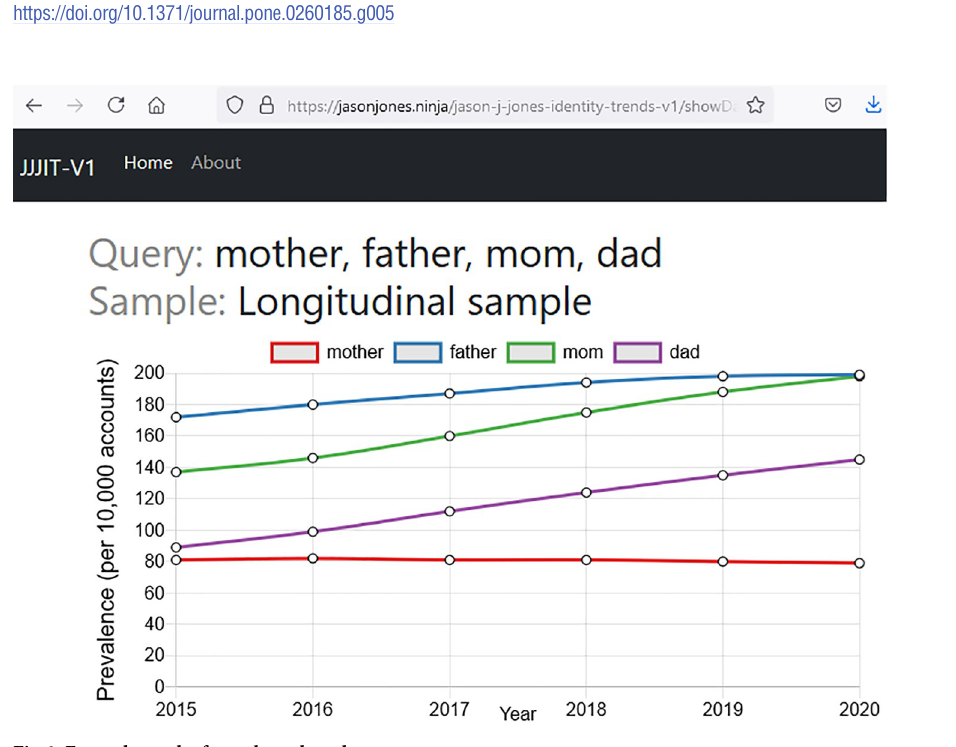
PLOS ONE | https://doi.org/10.1371/journal.pone.0260185 November18,